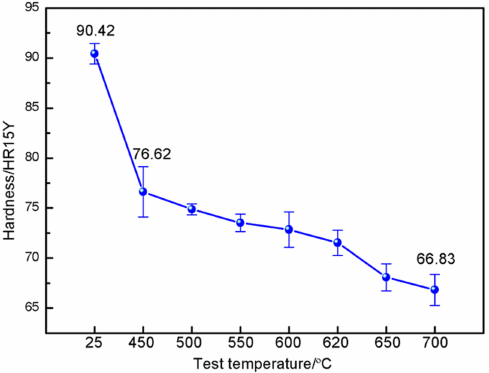
Figure 3. Effect of temperature on hardness on the as-sprayed CuAl seal